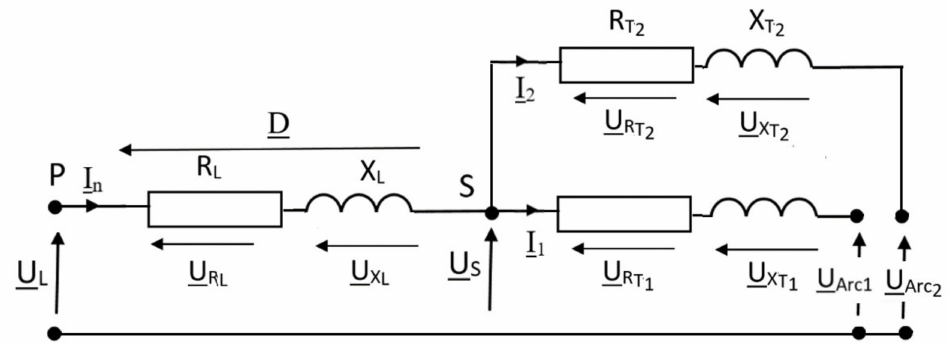
Figure 13. Scheme of the power supply system of a steelworks with two arc furnaces including